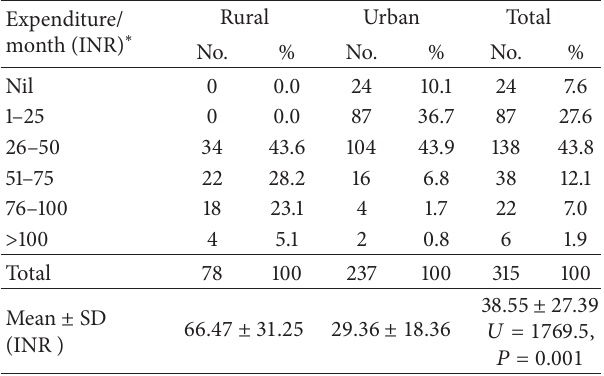
Table 3: Distribution of the study population according to